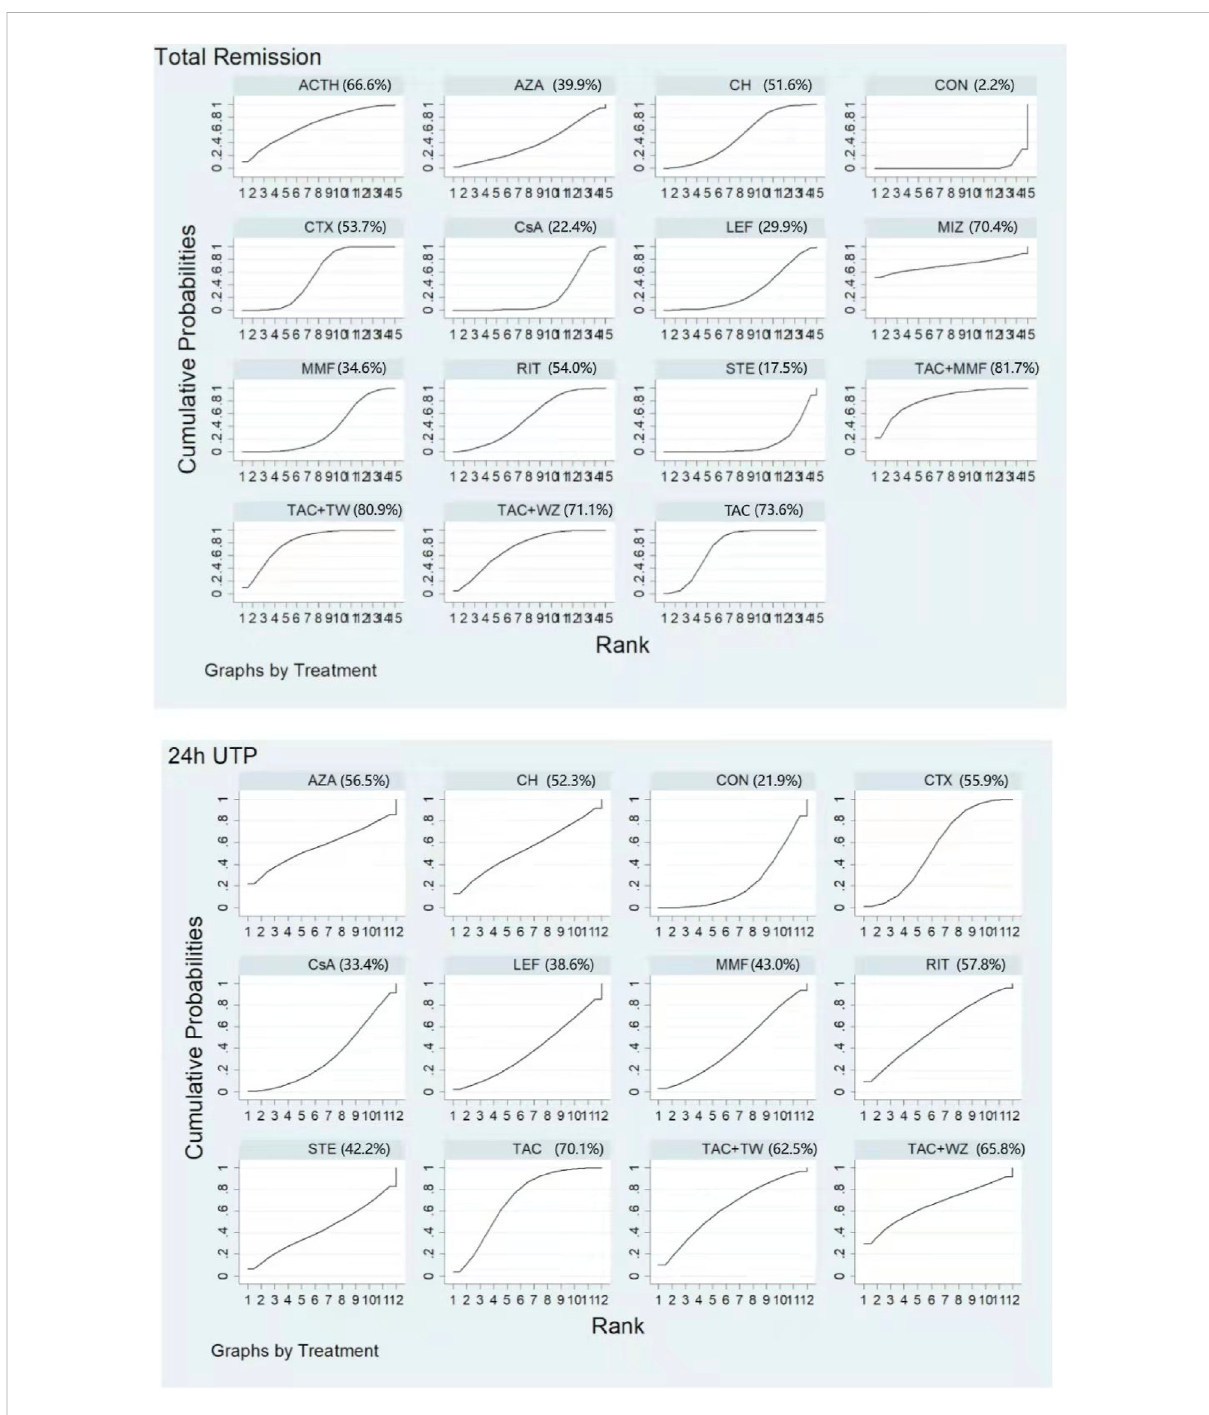
FIGURE 5 Rankings of SUCRA for all treatments. ACTH, adrenocorticotropic hormone; AZA, azathioprine; CH, chlorambucil; CON, non- immunosuppressive therapies (the control group); CsA, cyclosporine; CTX, cyclophosphamide; LEF, le fl unomide; MMF, mycophenolate mofetil; MZB, mizoribine; RIT, rituximab; STE, steroids; TAC, tacrolimus; and TAC + MMF, tacrolimus-combined mycophenolate